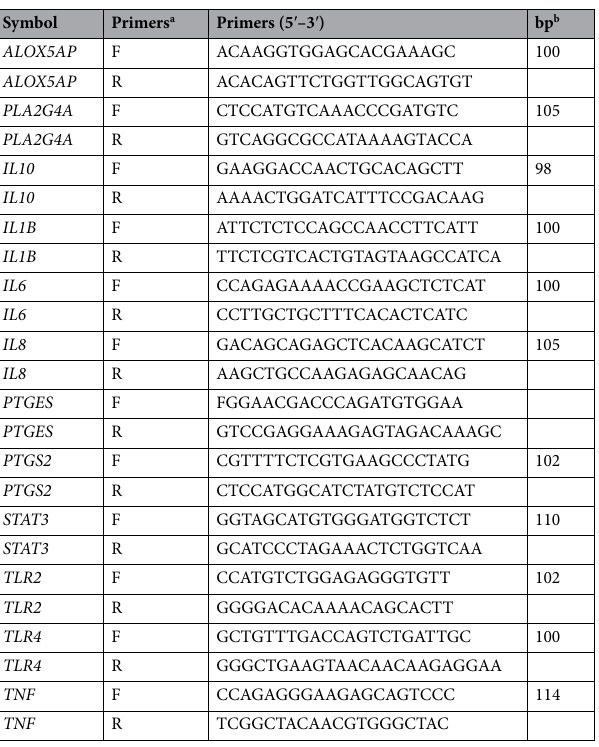
Table 2. Features of used primers for qPCR analysis. Sequence and amplicon size of primers for Bos taurus used to analyze gene expression. a Primer direction (F—forward; R—reverse). b Amplicon size in base pair Progesterone measurement. Progesterone concentrations measured by enzyme-linked immunosorbent assay (ELISA) kit (DIAPLUS, North York, Canada, Cat No. DP 4926). The intra- and inter assay coefficients of variation were 2.21 and 3.56% respectively. Gene expression.